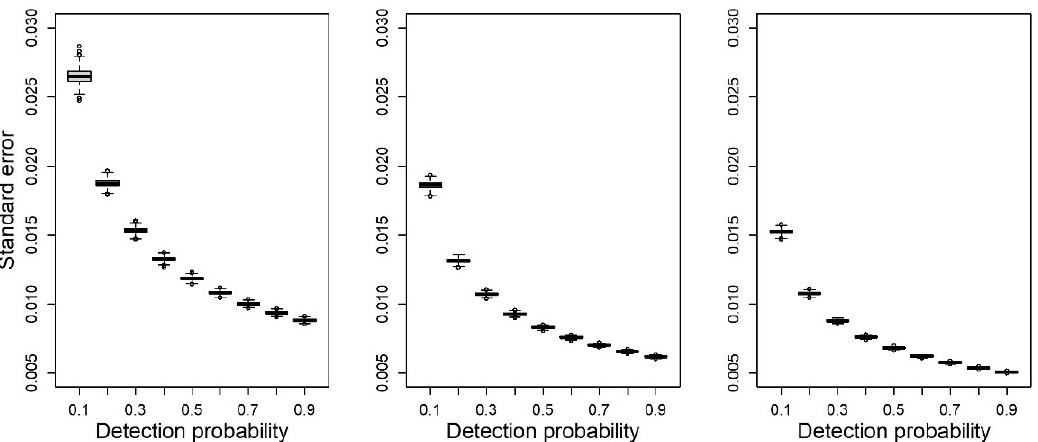
Figure 3. Results of the simulations estimating the assessment of decline in species with different detection probabilities. In the first row of plots, the bars represent the proportion of simulations detecting a significant ( α = 0.05) decline of the target species. The actual average population size of populations ( L ) ranged from 30 to 90. In the second row, the boxplots show the distribution of the estimated trends across the 1000 simulation replicates. The red line represents the actual trend. In the third row, the boxplots show the distribution of the standard errors of the estimated trends across the 1000 replicates.